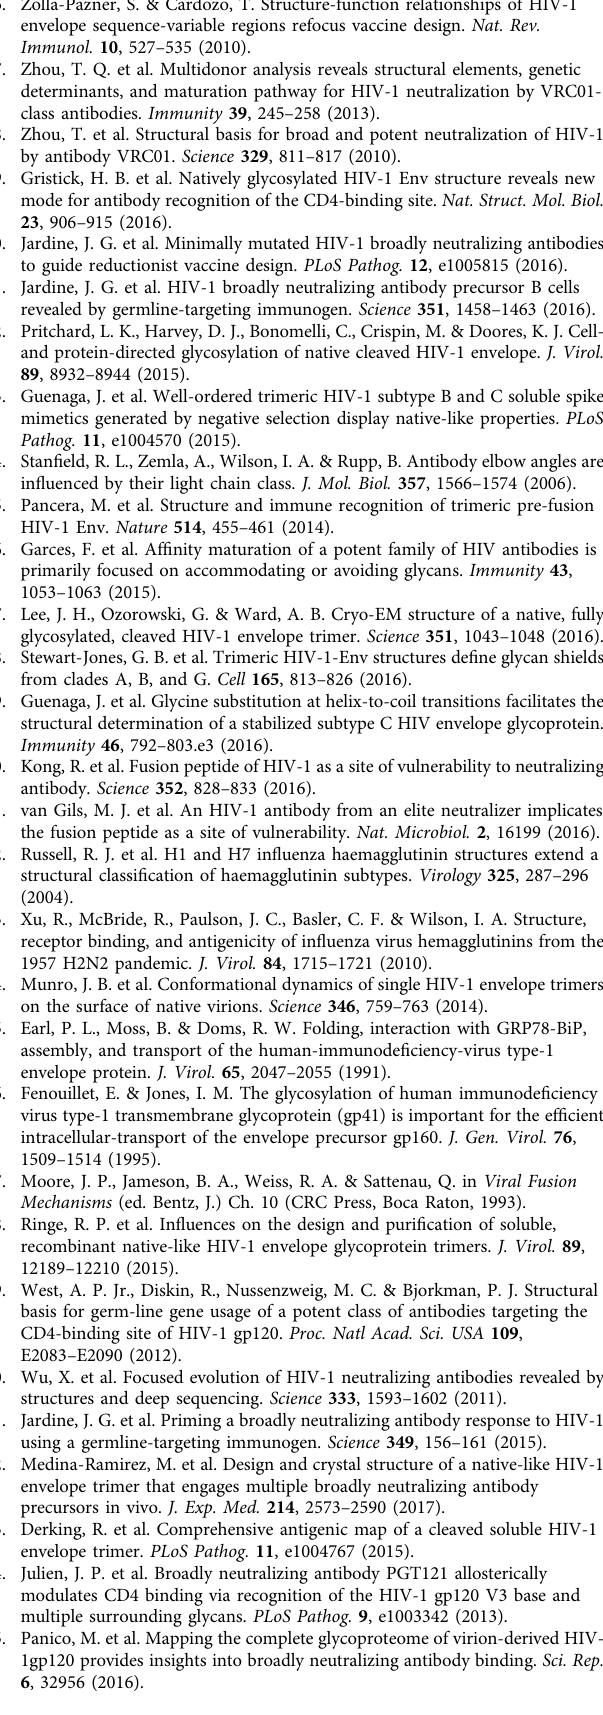
Data availability . The coordinates and structure factors reported in this manu- script have been deposited in the Protein Data Bank (PDB) with accession codes 6AVN and 6B0N. The authors declare that all other data supporting the fi ndings of this study are available within the article and its Supplementary Information fi les, or are available from the authors upon